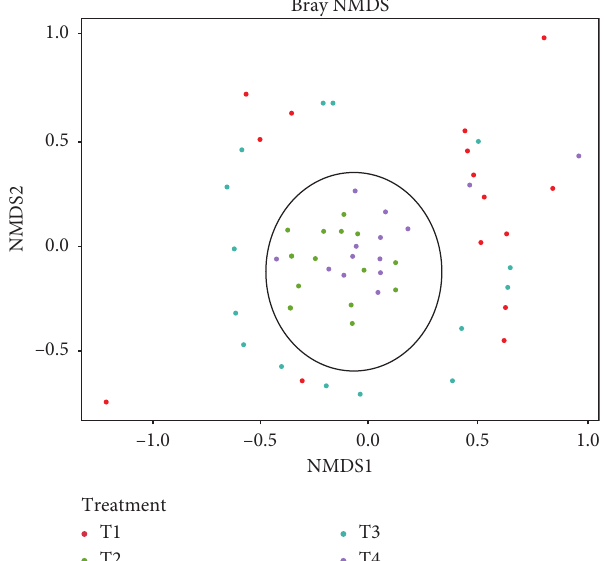
Figure 4: Nonmultidimensional scaling (NMDS) showing ASVs between hydrocarbon (T2, T4) and nonhydrocarbon (T1, T3) treatments. T1 � plant species only ( G. barbadense, H rufa Tdiversifolia, O longistaminata. and S. arundinaceum ), T2 � Plant species and hydrocarbon (0, 75g · kg − 1 ), T3 � Plant species and manure (0, 2 tha − 1 ), and T4 � Plant species, manure,